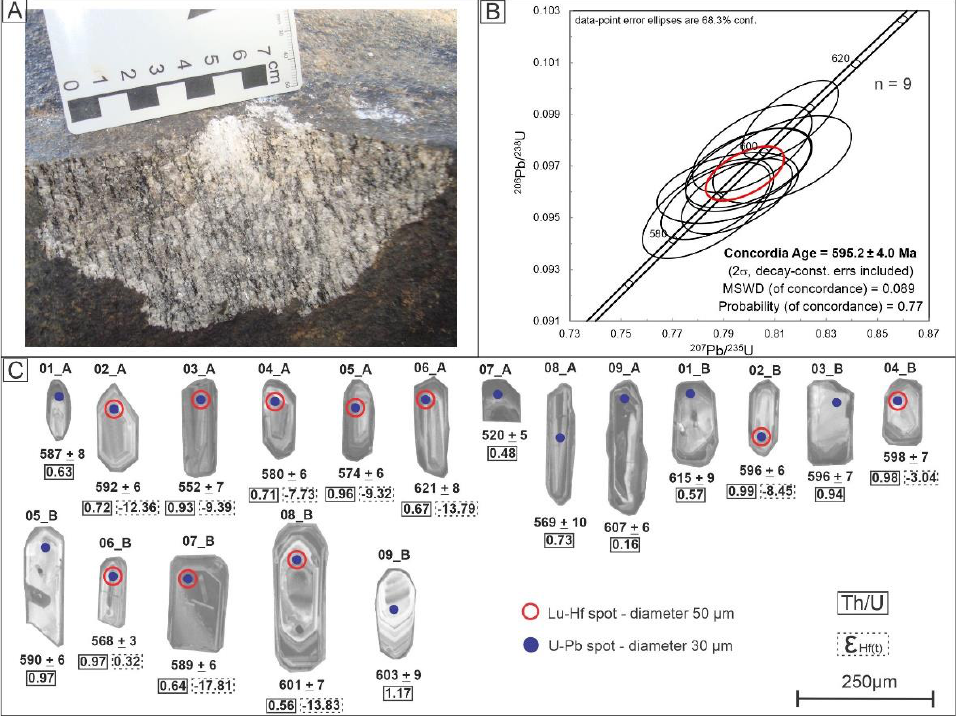
Figure 3. ( A ) Representative sample of Muniz Freire orthogneiss from the point SAIC-02. ( B ) Con- cord age for the sample SAIC-02.A. ( C ) Cathodoluminescence image of the analyzed zircon